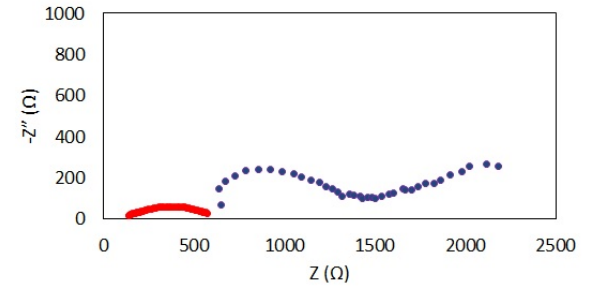
Figure 4. Nyquist plots of a microtubular SOFC prototype at 500 °C, before (red) and after (blue) a hydrogen leak